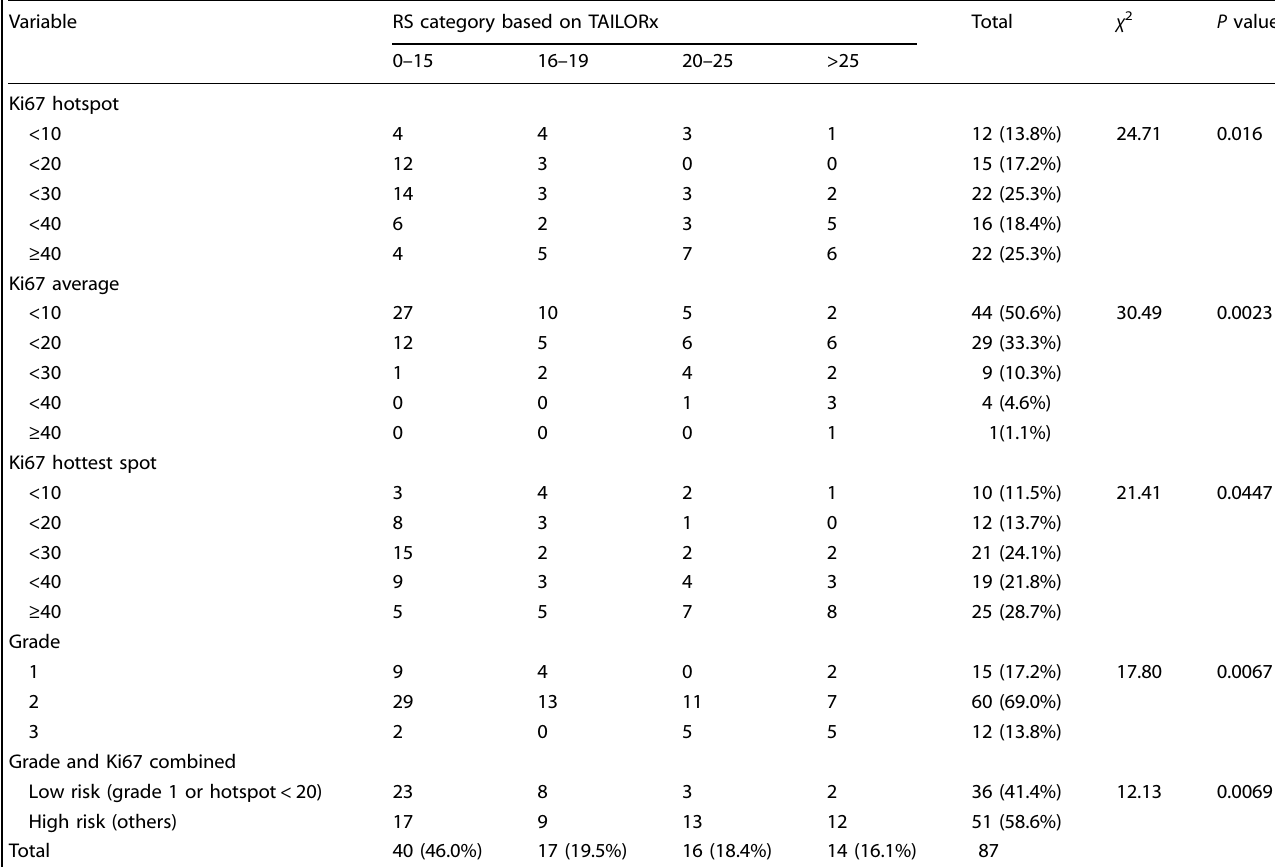
Table 2. Correlation between Ki67 labeling indexes/tumor grade and 21-gene recurrence score as categorical variables in women age ≥ 50. Variable RS category based on